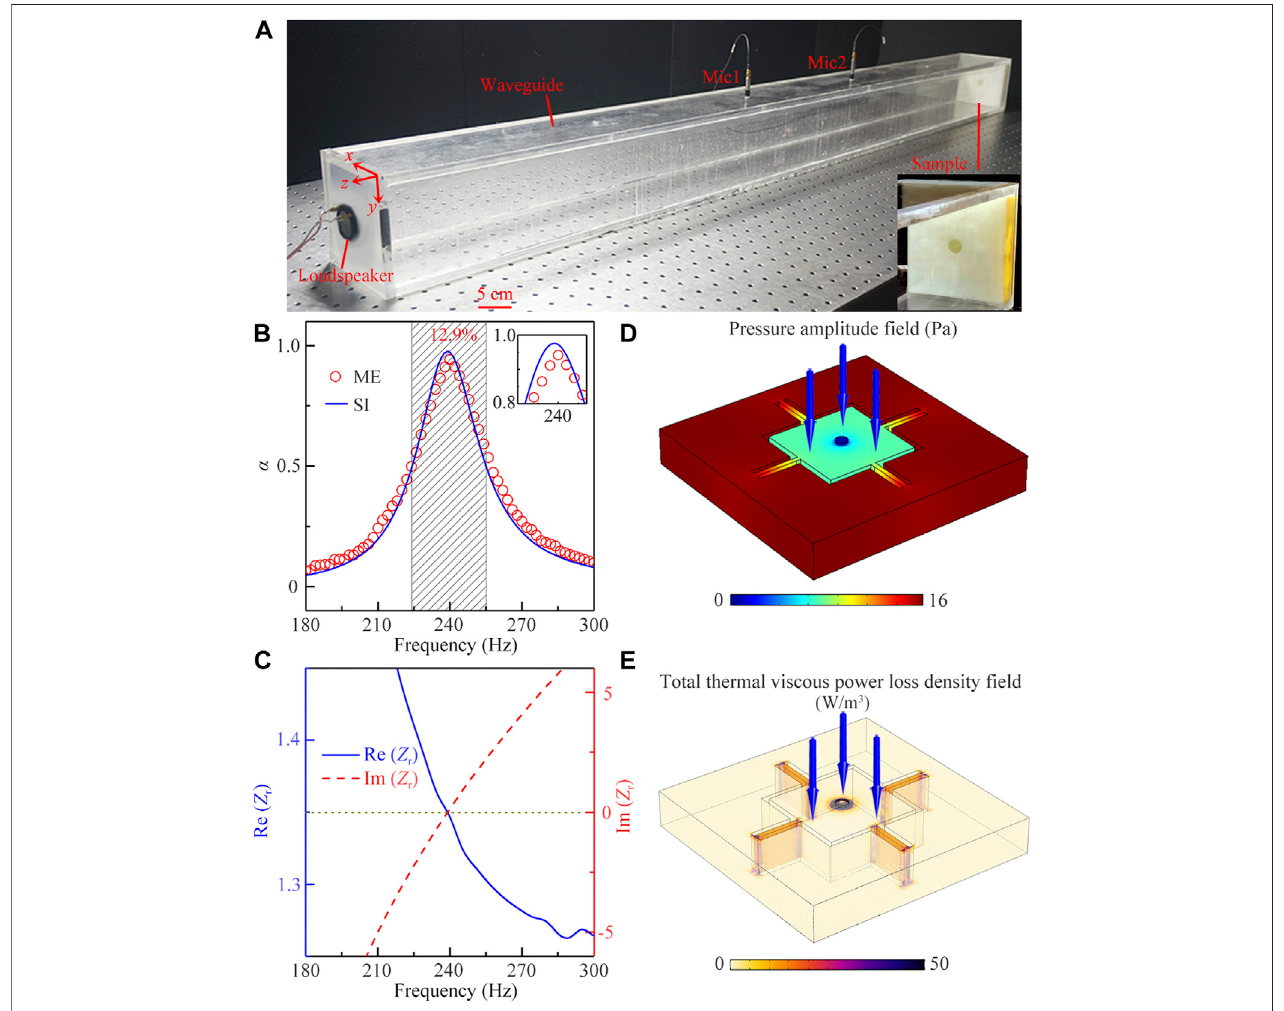
FIGURE 3 | (A) Experiment set-up of sound absorption. (B) Simulated (blue solid line) and measured (red open circles) sound absorption spectra of the unit. (C) Real and imaginary parts of relative acoustic impedance Z r of the unit. Distributions of (D) the pressure amplitude and (E) total thermal viscous power loss density in the unit excited by a normal incident wave (blue solid arrows) at 239